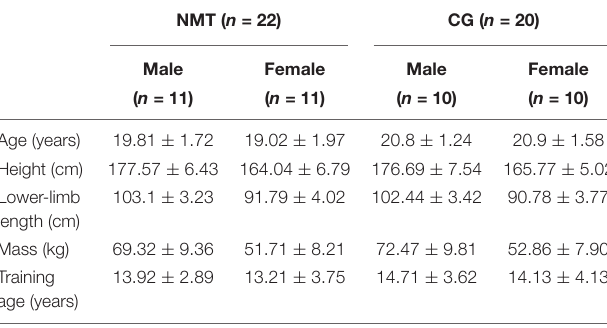
TABLE 1 | Demographic characteristics of the participants at the